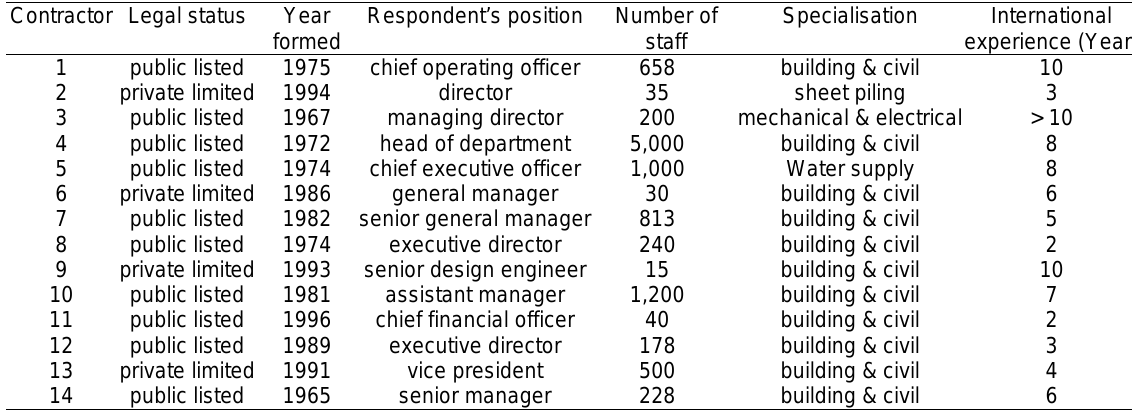
Table 1: Surveyed contractor pro fi